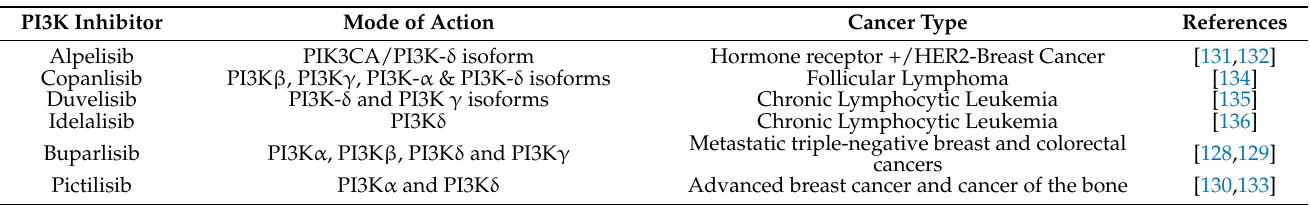
Table 1. Examples of available PI3K inhibitors and their mode of action in different cancers. PI3K Inhibitor Mode of Action Cancer